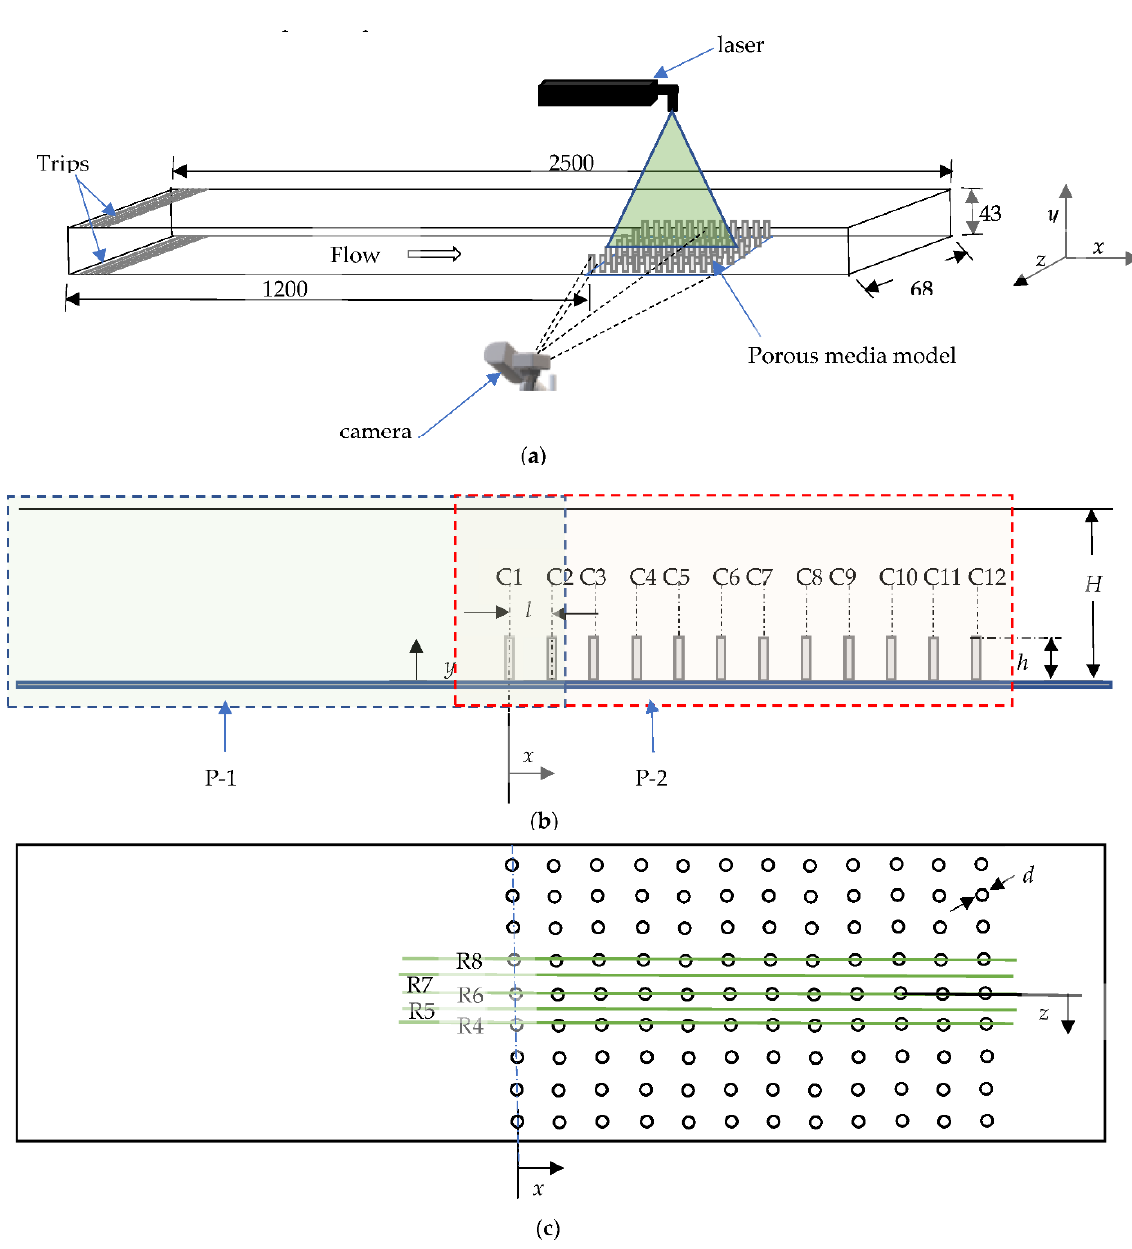
Figure 1. Schematics showing ( a ) the model test channel and PIV system; ( b ) front view showing details of porous arrangements in the test channel as well as streamwise planar coverage of PIV measurements (shown using blue and boxes with dashed line boundaries); and ( c ) top view of the porous model arrangement in the model test channel with green lines indicating lateral locations of measurement with the laser sheet. All numeric dimensions are in millimeters.